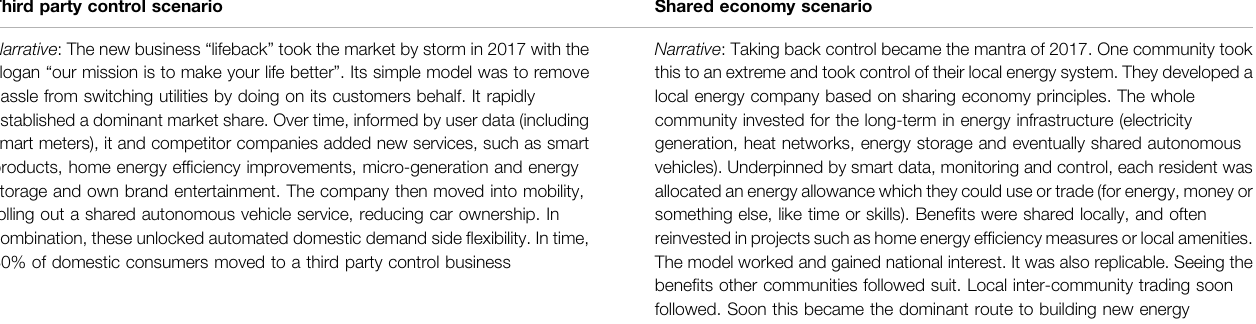
TABLE 1 | Workshop materials - narrative description, energy system implications and assumptions of the two